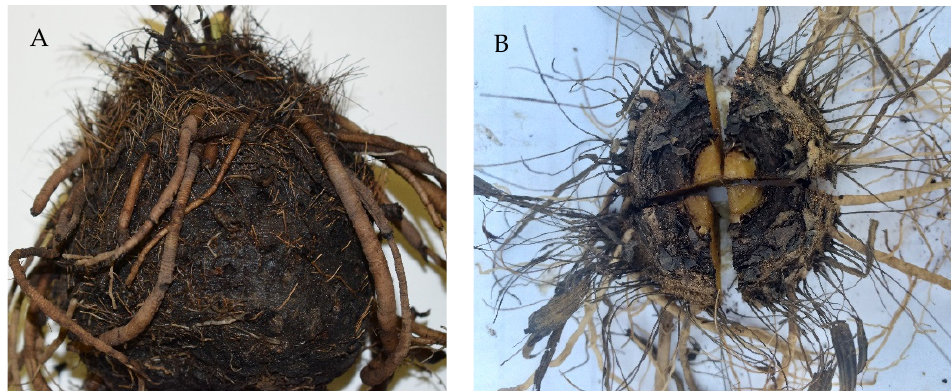
Figure 4. A full Hypoxis hemerocallidea corms (on the left side ) and the top view of the corm cut into four pieces (on the right side ).